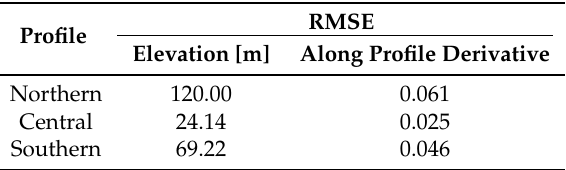
Table 5. RMSE of elevation and along profile derivative of the SfS profiles to the reference DTM profiles from Figure 9 at a resolution of